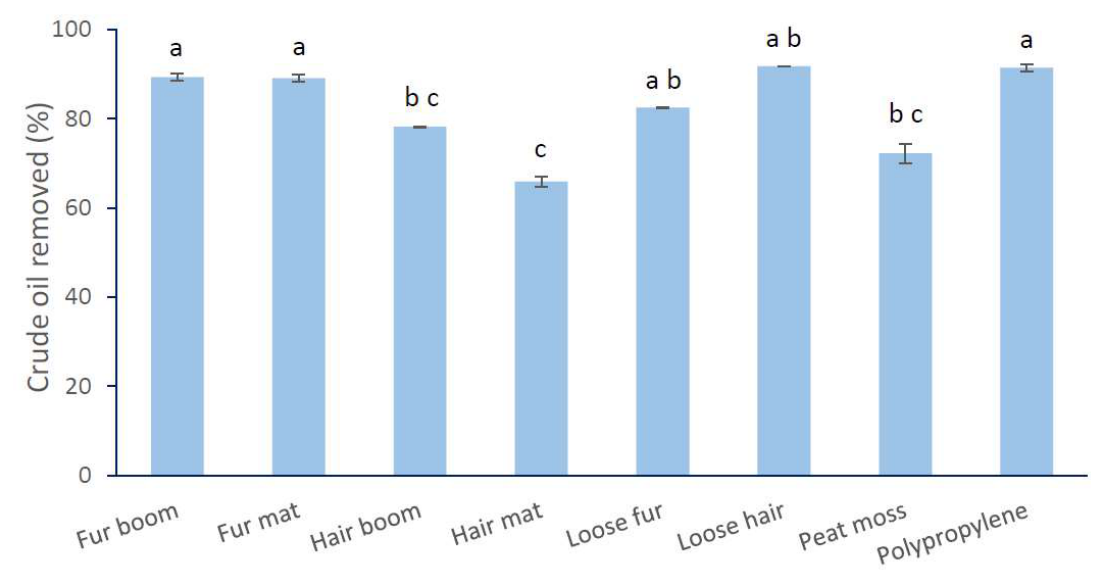
Figure 2. Crude oil adsorbed by different materials on a non-porous, glass surface.